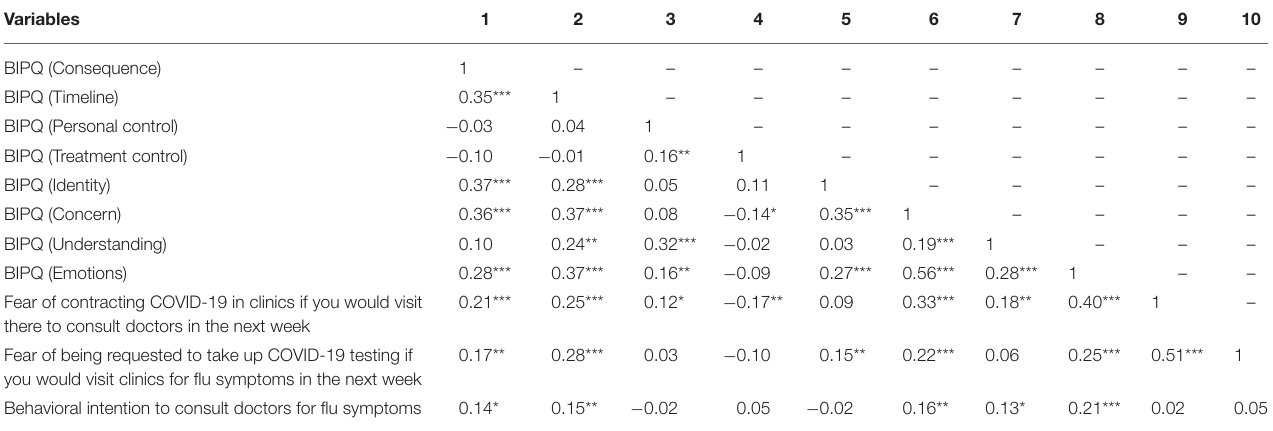
TABLE 3 | Spearman correlation between variables of interest ( N = 300).